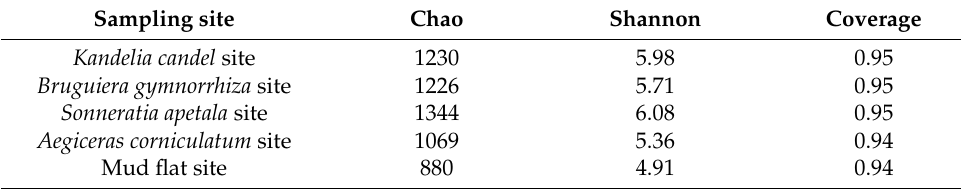
Table 3. Bacterial richness and diversity indices in the sediments.